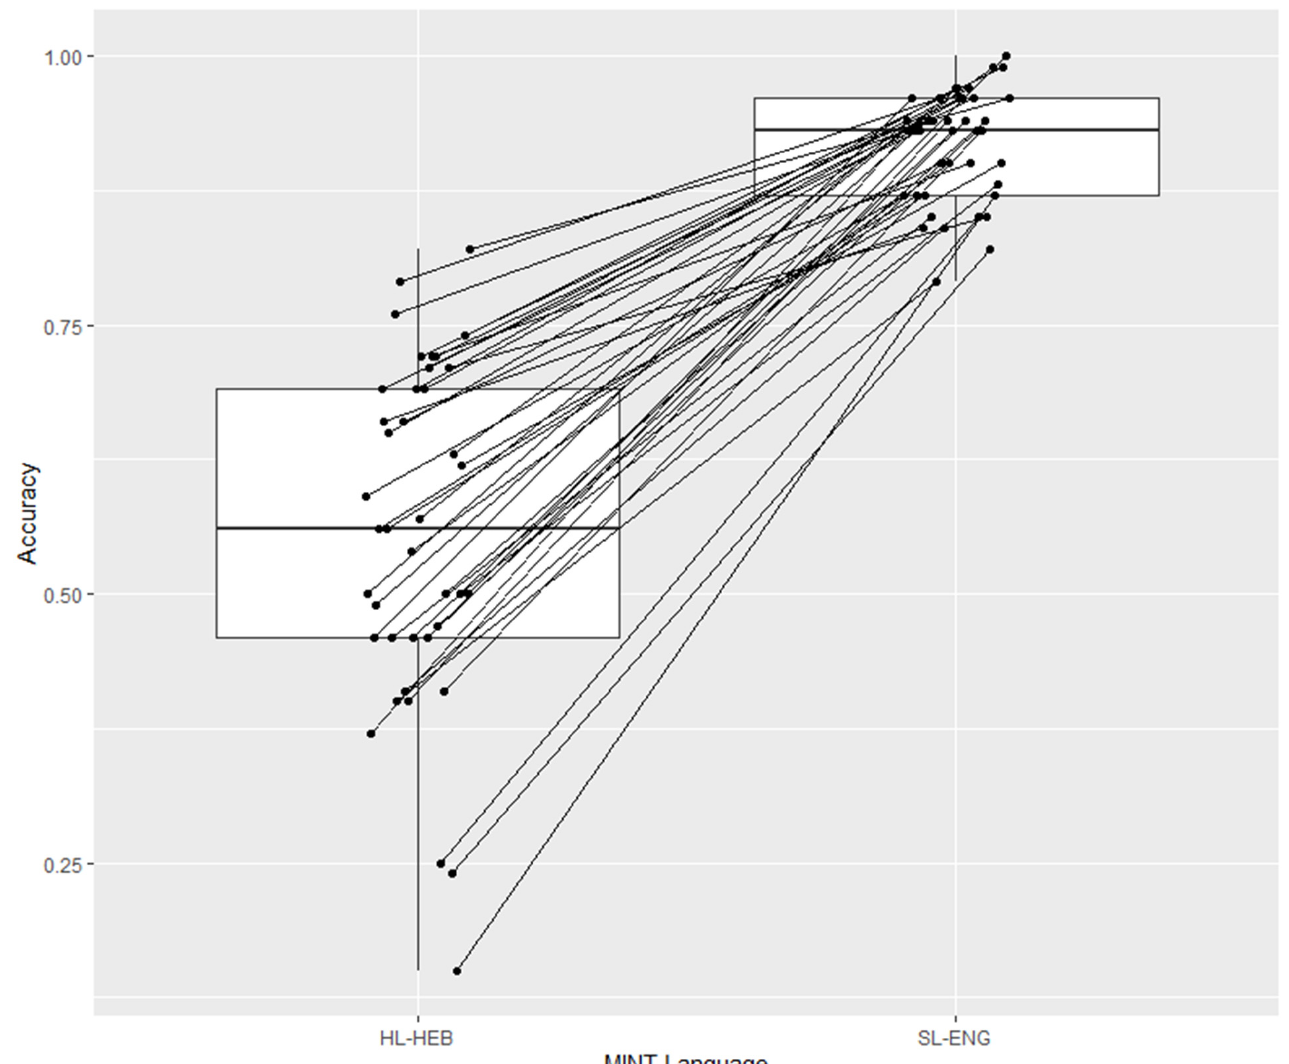
Figure 1. Hebrew HSs’ Performance on HL and SL MINTs.